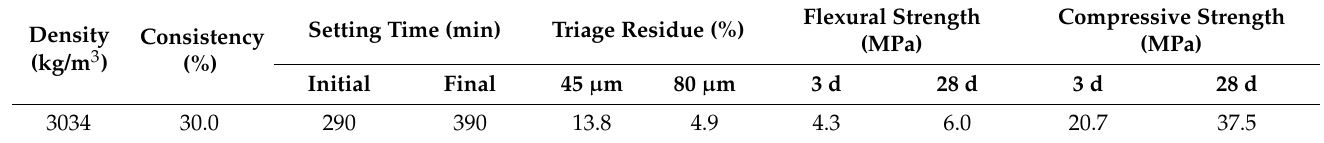
Table 1. Basic physical properties of cement.